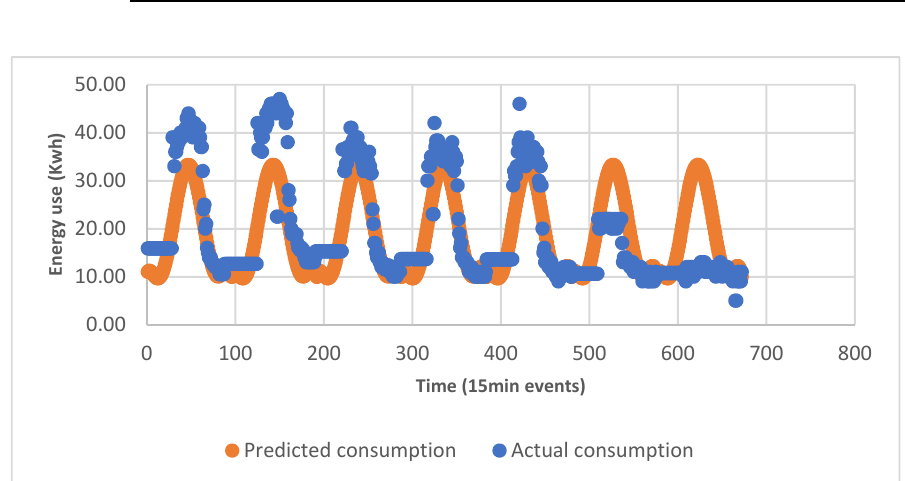
Figure A5. A comparison of the first week of spring’s energy use to the PR predicted energy use.